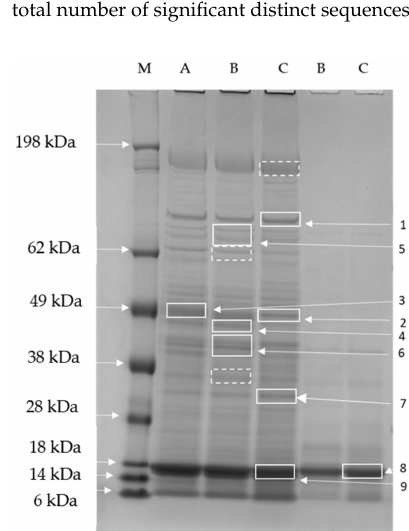
Figure 5. Representative SDS-PAGE (4–12%, Coomassie staining) of fractions obtained after size exclusion chromatography of cellular extracts of samples A, B, and C. Right: Lane 1, molecular mass marker (M) (kDa); lanes 2–4 fraction 11 from samples A (A), B (B), and C (C), respectively; lanes 5–6, fraction 14 from samples B (B) and C (C), respectively. Rectangles indicate bands excised and analyzed by mass spectrometry: continuous line rectangles indicate bands that provided protein identifications (Table 2), while dotted line rectangles indicate bands excised and analyzed by mass spectrometry that did not result in protein